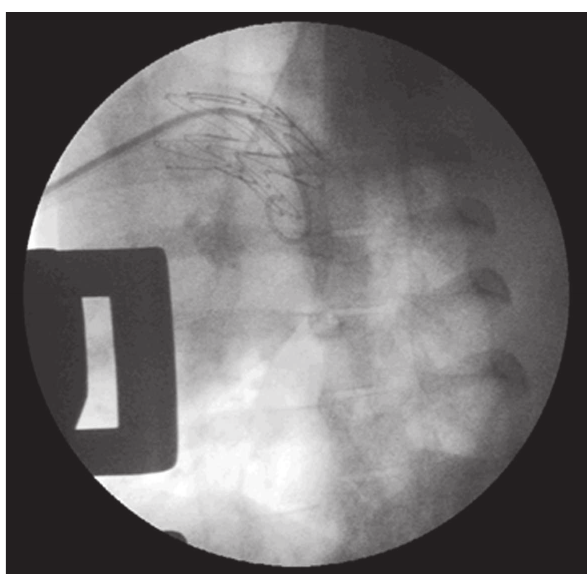
Fig. 4. Imagem radioscópica da válvula posicionada após implante